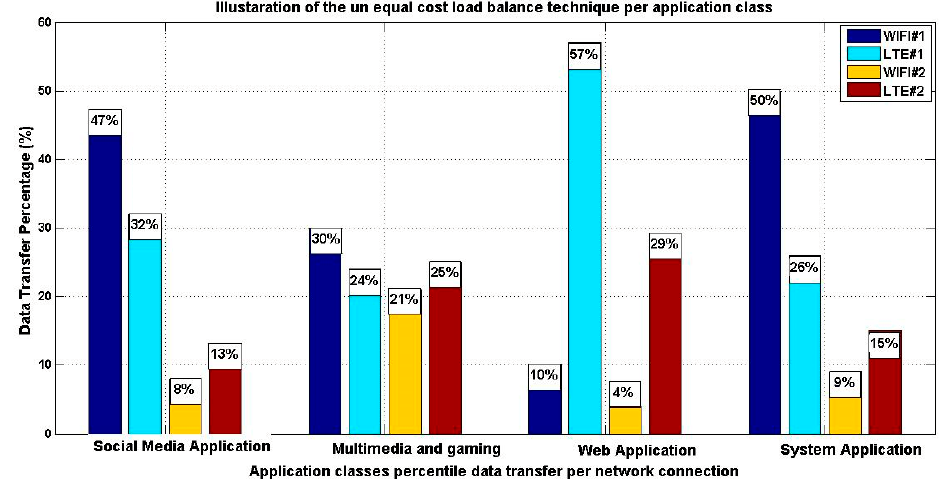
Figure 8. Illustration of the unequal cost load balance per application class using AHP.